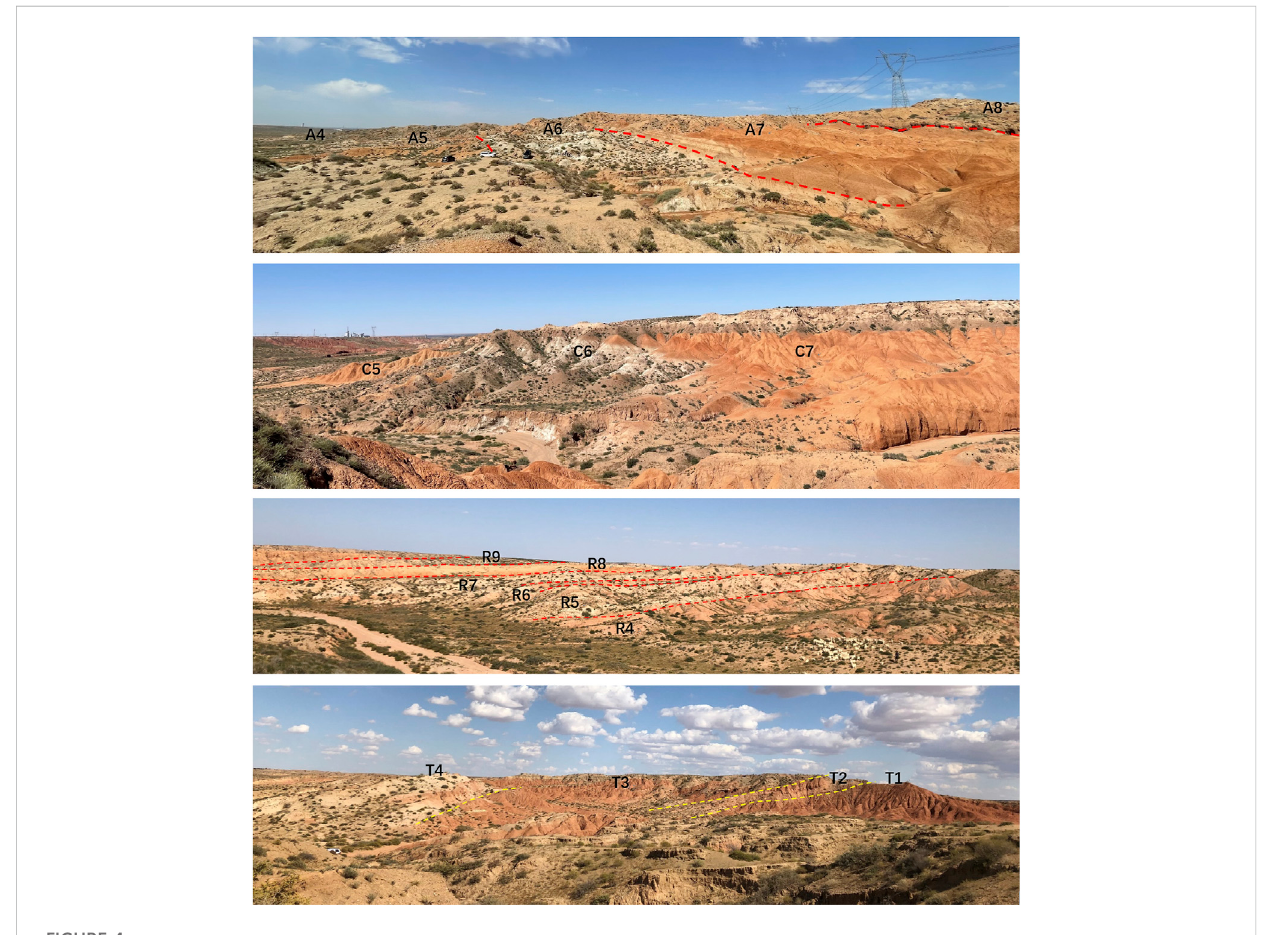
FIGURE 4 Outcrop photographs of selected measured